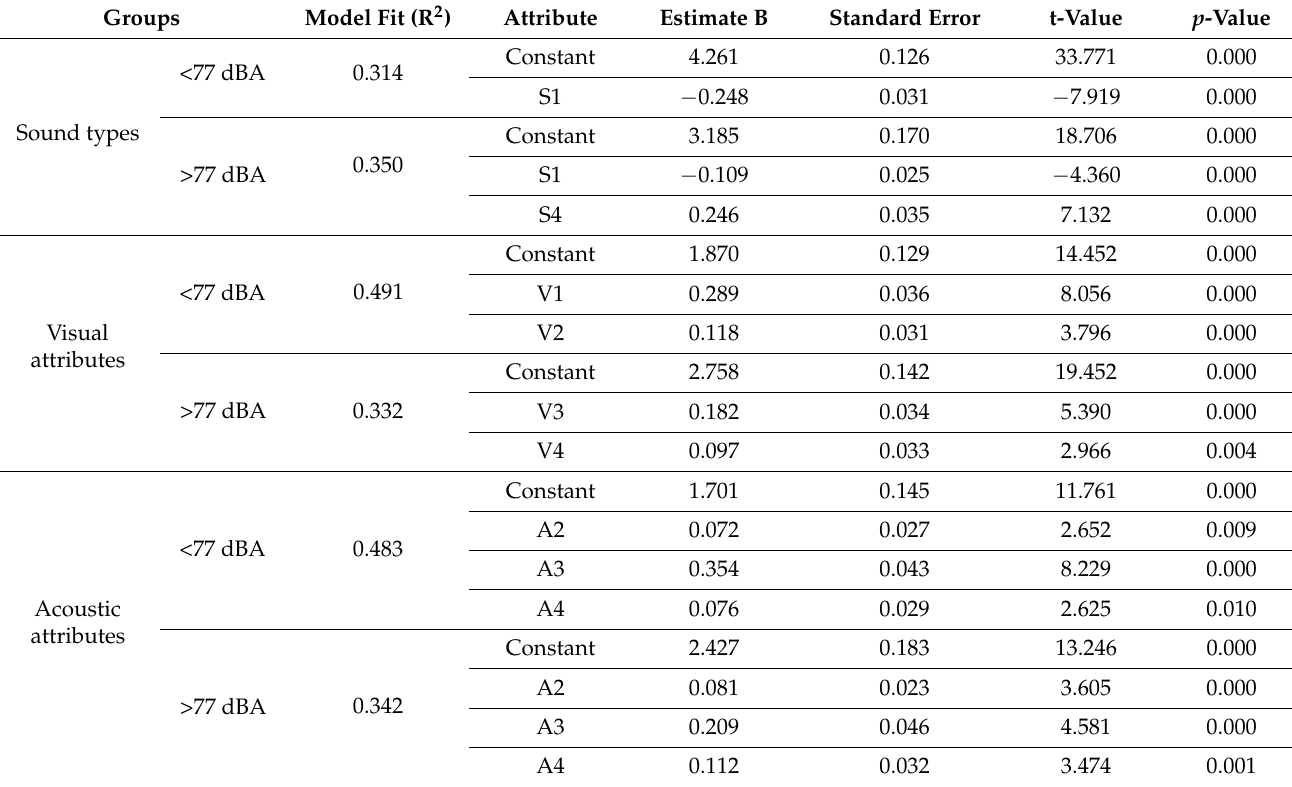
Table 6. Model fit and estimation of B coefficients of